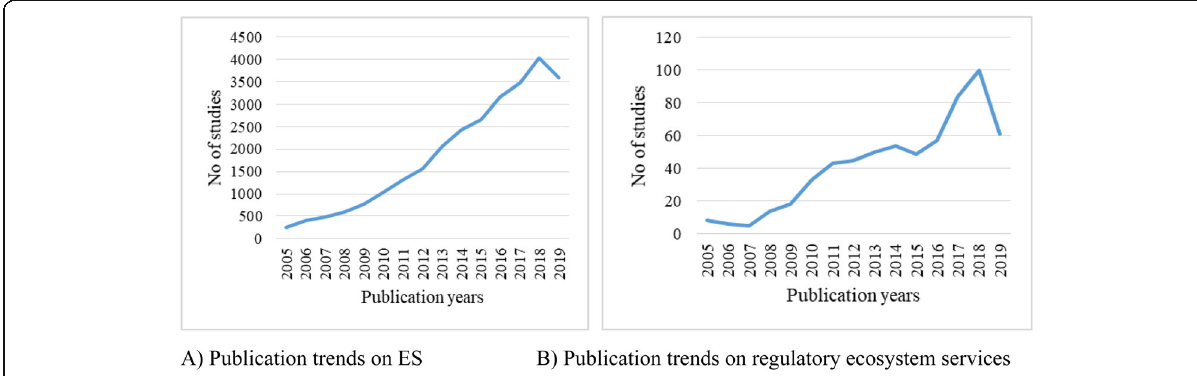
Fig. 1 The number of papers published annually from 2005 to April 2019. a Publication trends on ES. b Publication trends on regulatory ecosystem